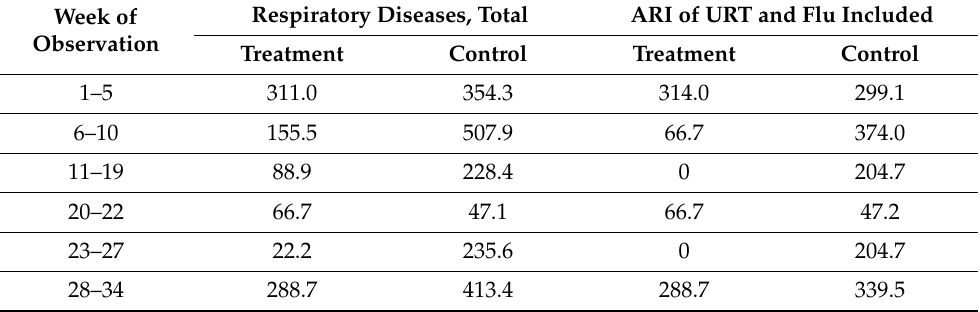
Figure 3. The incidence rate of diseases of the skin and subcutaneous tissue in the control group by observation weeks, ‰.